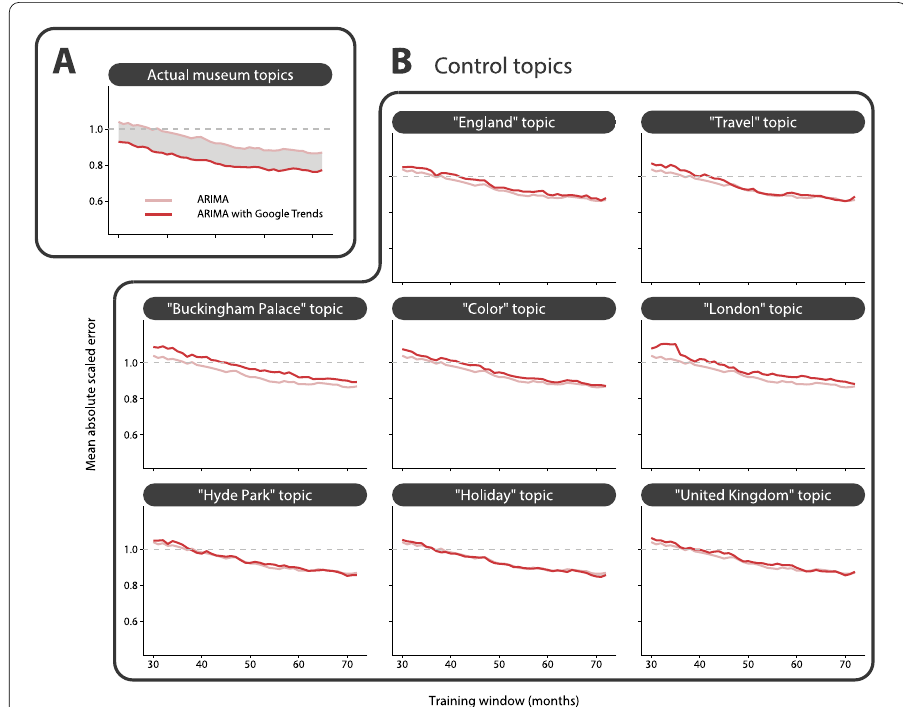
Figure 2 Verifying the value of data on Google searches for museums or galleries. Are estimates of visitor numbers improved only when the GoogleTrends data relates to the museum or gallery in question, or would any data from GoogleTrends improve our estimates, suggesting that our findings might reflect a spurious correlation? To address this question, we repeat our analysis using data from GoogleTrends for control topics with limited or no relation to museums and galleries: England , Travel , BuckinghamPalace , HydePark , London , UnitedKingdom , Holiday , and Color . Again, we generate monthly estimates of visitor numbers for all museums using rolling training windows between 30 months and 72 months, for both a baseline ARIMA model and a model enhanced with GoogleTrends data. ( A ) For comparison, we first depict the results across all museums when the actual GoogleTrends topics for each museum are used (for example, the TateModern topic for the TateModern gallery). We observe that the mean absolute scaled error (MASE) is lower when GoogleTrends data is included, regardless of training window size. ( B ) We compare these findings to results when Google Trends data for our eight control topics is used. Here, we find that the GoogleTrends model does not perform better than the baseline. Visual inspection suggests that adding irrelevant GoogleTrends data to the model in fact slightly increases the MASE. In the context of our previous findings, this provides further evidence that data on search queries for a specific museum or gallery contains valuable information that can be used to improve rapid estimates of visitor